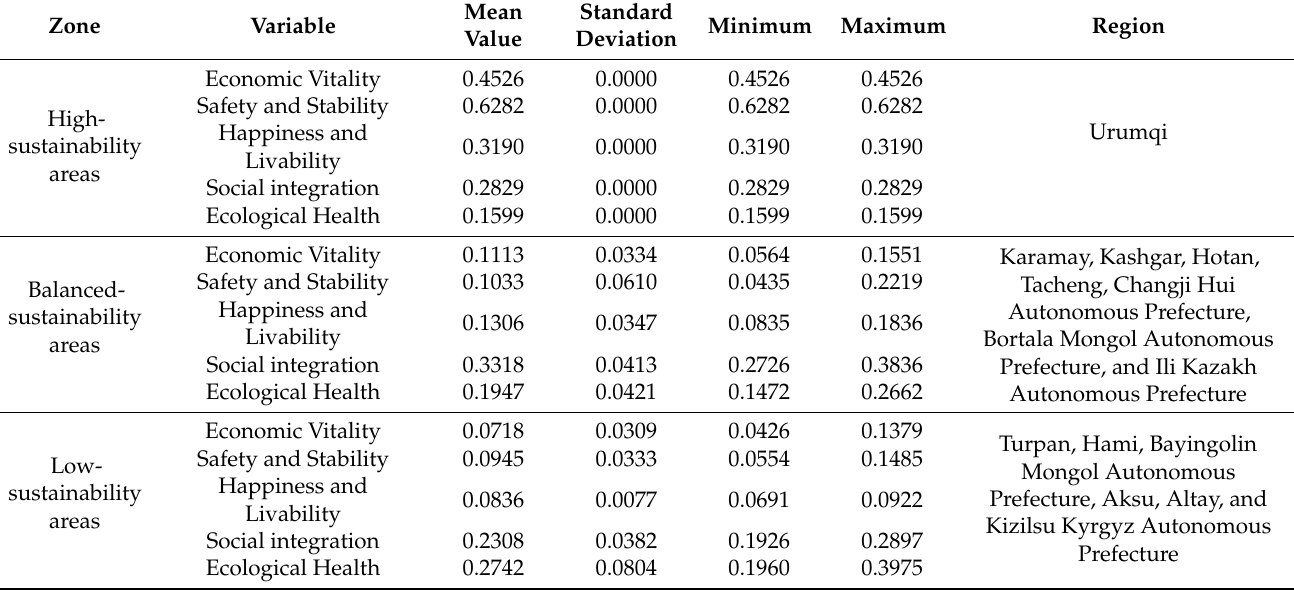
Table 2. Statistics of urbanization sustainability zoning in